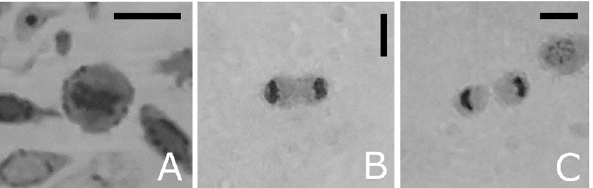
Figure 8. Light microscopy images of haemocyte semithin sections from T. molitor , showing mitotic stages. ( A ) Metaphase. ( B ) Telophase, ( C ) Cytokinesis. Bars: 5 μ m.